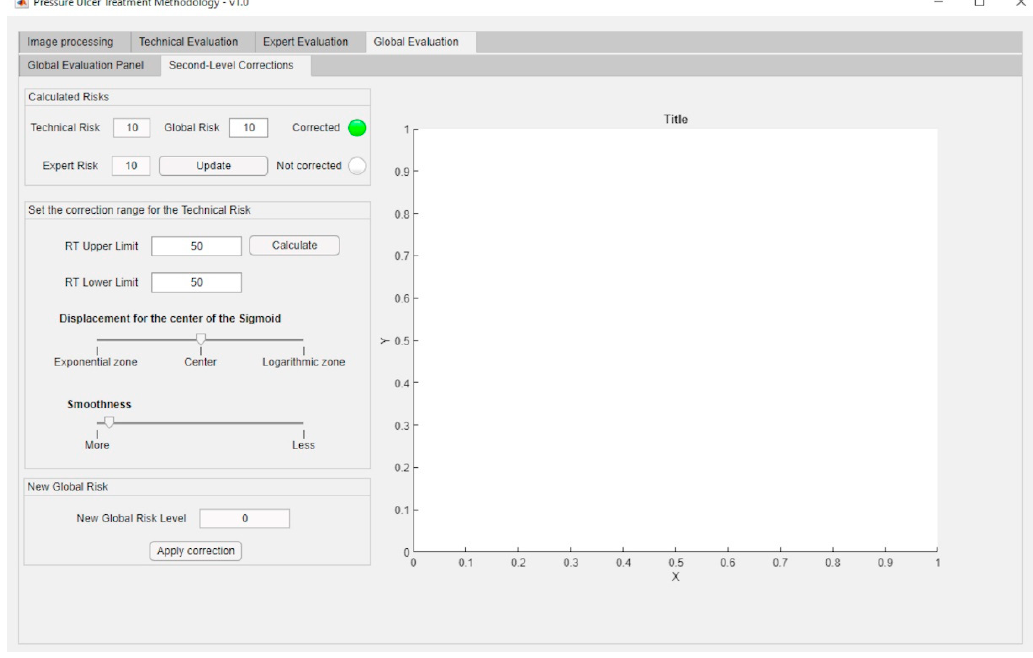
Figure 17. Second-level corrections panel.